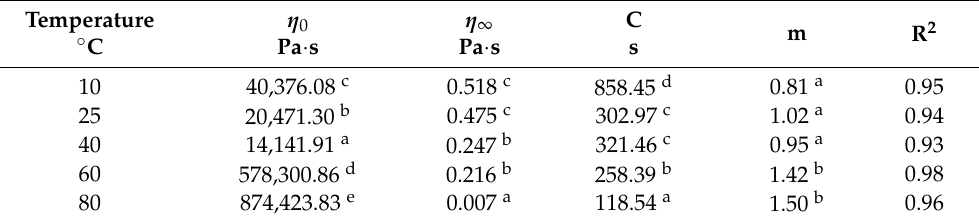
Table 2. Adjustment parameters of Cross model to viscous curves of hydrocolloids from Pereskia bleo leave extracted at pH 3, at 10, 25, 40, 60 y 80 ◦ C. η 0 : zero-shear viscosity, η ∞ : infinite shear viscosity, m: Cross-rate constant, and C: known as the Cross time